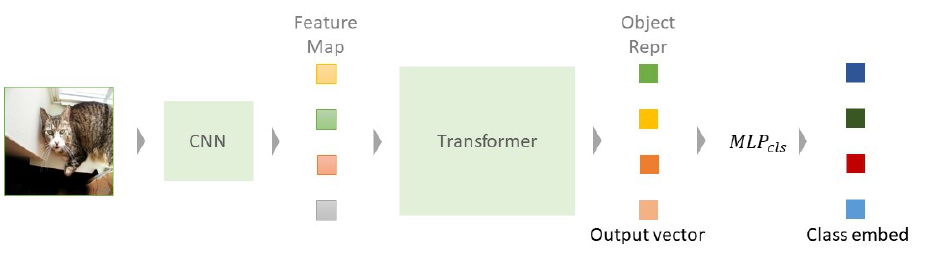
Figure 6. The overview of class embedding. This is generated after the transformer’s output vector has passed through the